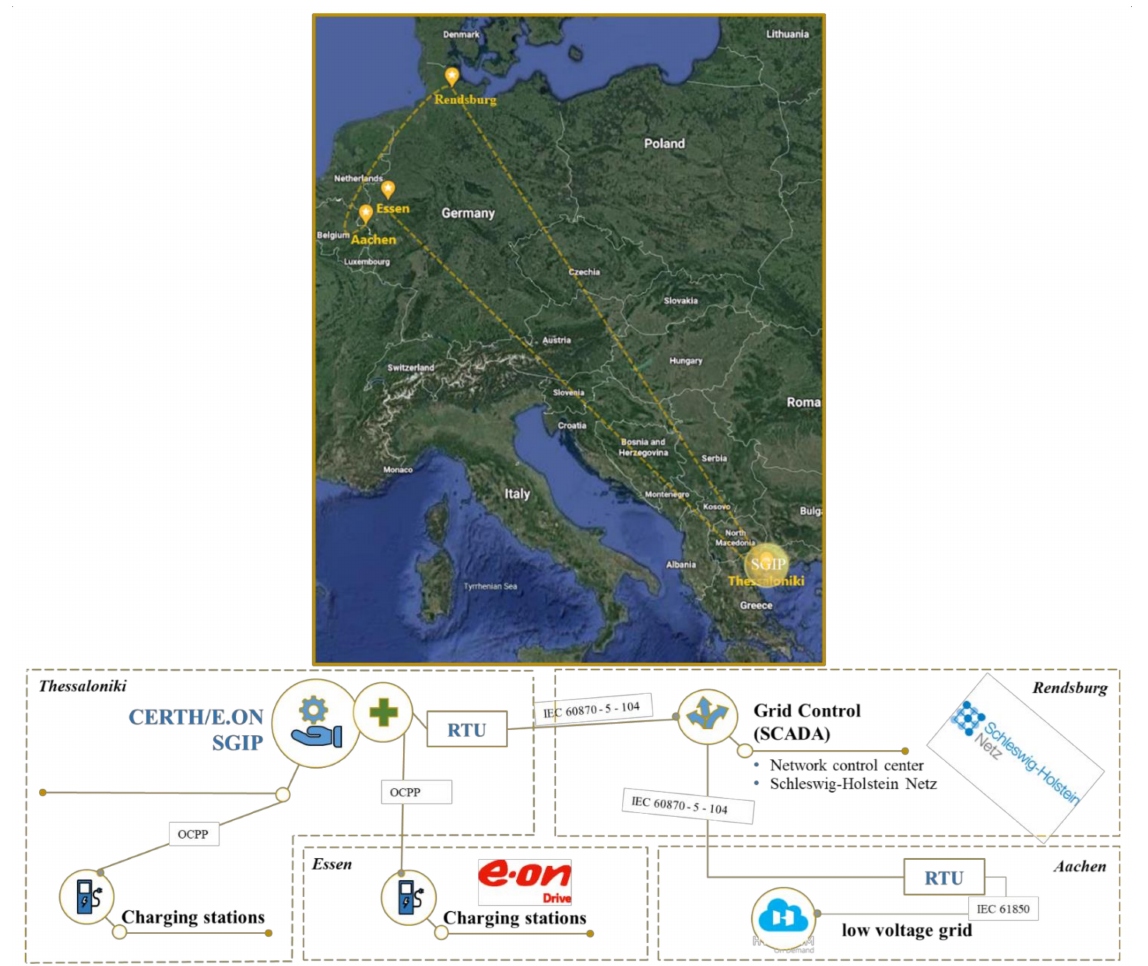
Figure 1. MEISTER information and communication technology (ICT) platform.